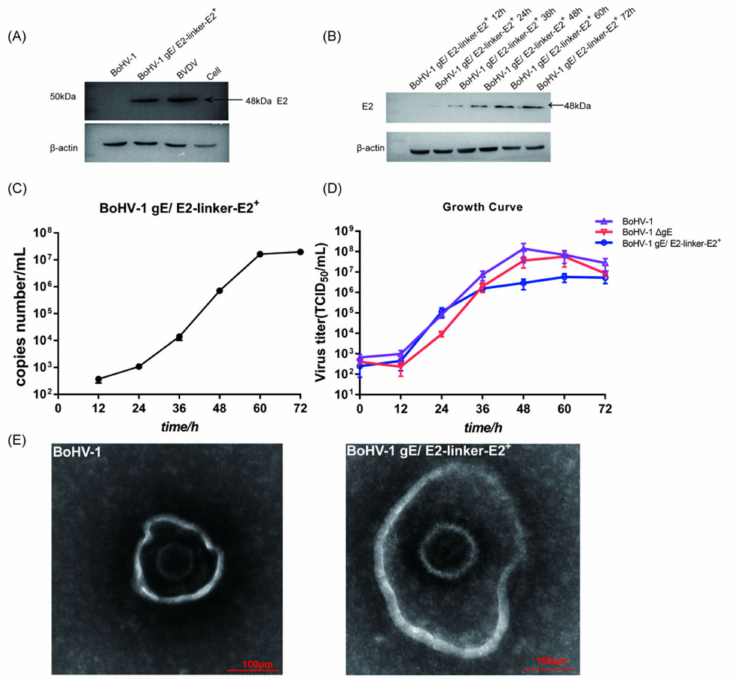
Figure 2. The insertion of the gene did not change the viral replication ability and particle morphology. ( A ) Western blot analysis of BoHV − 1 gE/E2 − Linker − E2 + with chimeric expression of BVDV − 1 E2 and E2-Linker-E2 using BVDV − 1 E2-specific mAb. ( B ) Evaluation of E2-linker-E2 expression levels of BoHV − 1 gE/E2 − Linker − E2 + after inoculation of MDBK using BVDV − 1 E2-specific mAb. Expression of BVDV − 1 E2 protein in cells at 12, 24, 36, 48, 60, and 72 h. ( C ) Evaluation of E2-linker-E2 expression at mRNA levels using E2–E2 − F/R primers by RT-PCR. Calculation of the copy number of the recombinant virus genome based on the CT value of the standard curve. mRNA expression of the BoHV − 1 gE/E2 − Linker − E2 + genome was shown at 12, 24, 36, 48, 60, and 72 h, and the above experiments were independently replicated three times within each time-period. ( D ) Recombinant viruses were inoculated MDBK (MOI = 0.01). At 12, 24, 36, 48, 60, and 72 h, the virus titer was calculated using the Reed–Muench method, and the virus growth curve was plotted. ( E ) After phosphotungstic acid staining, the morphological characteristics of BoHV − 1 and other recombinant viruses were compared using electron